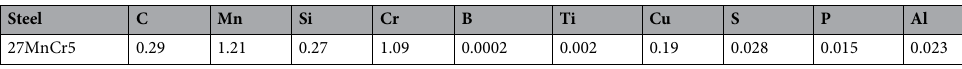
Table 2. Weight percentage chemical composition for the 27MnCr5.